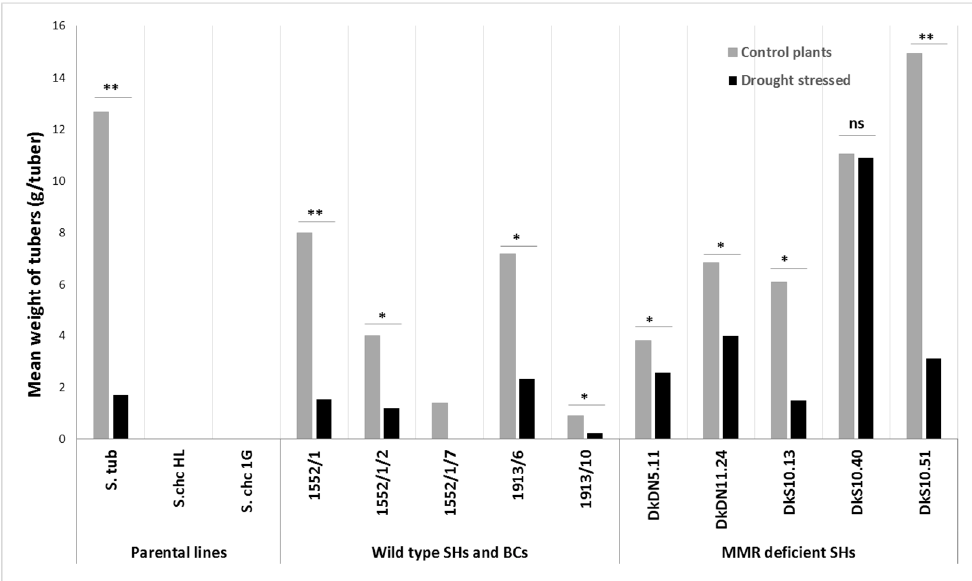
Figure 10. Mean weight of tubers of different genotypes (3 plants/genotype) after six weeks of water shortage in the greenhouse. Symbol * and ** denotes significant differences (* indicates p < 0.005, while ** indicates p < 0.001) in tuber weight accumulation between stressed and control plants; ns indicates a p > 0.005.